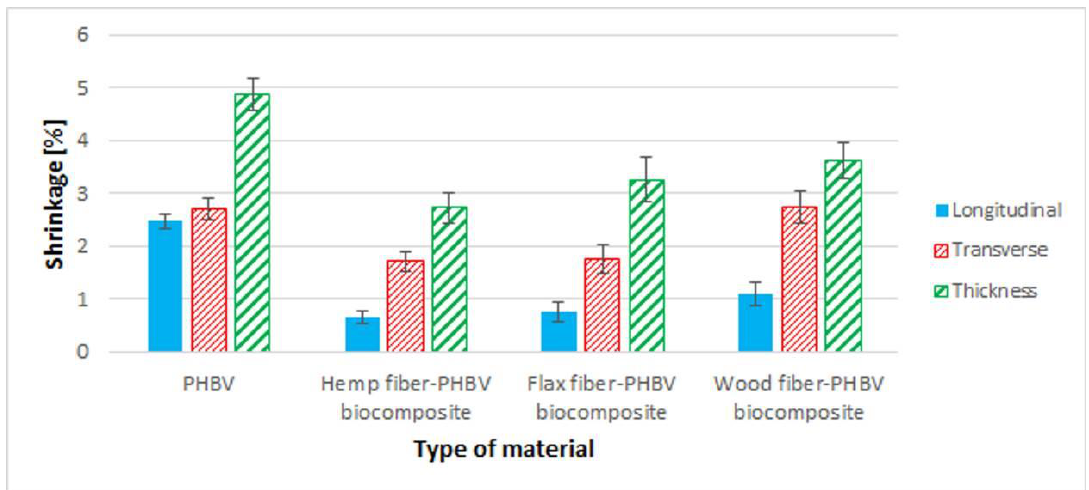
Figure 5. Shrinkage: longitudinal and transverse, in thickness for biocomposites with a variable type of filler and for pure PHBV biopolymer.